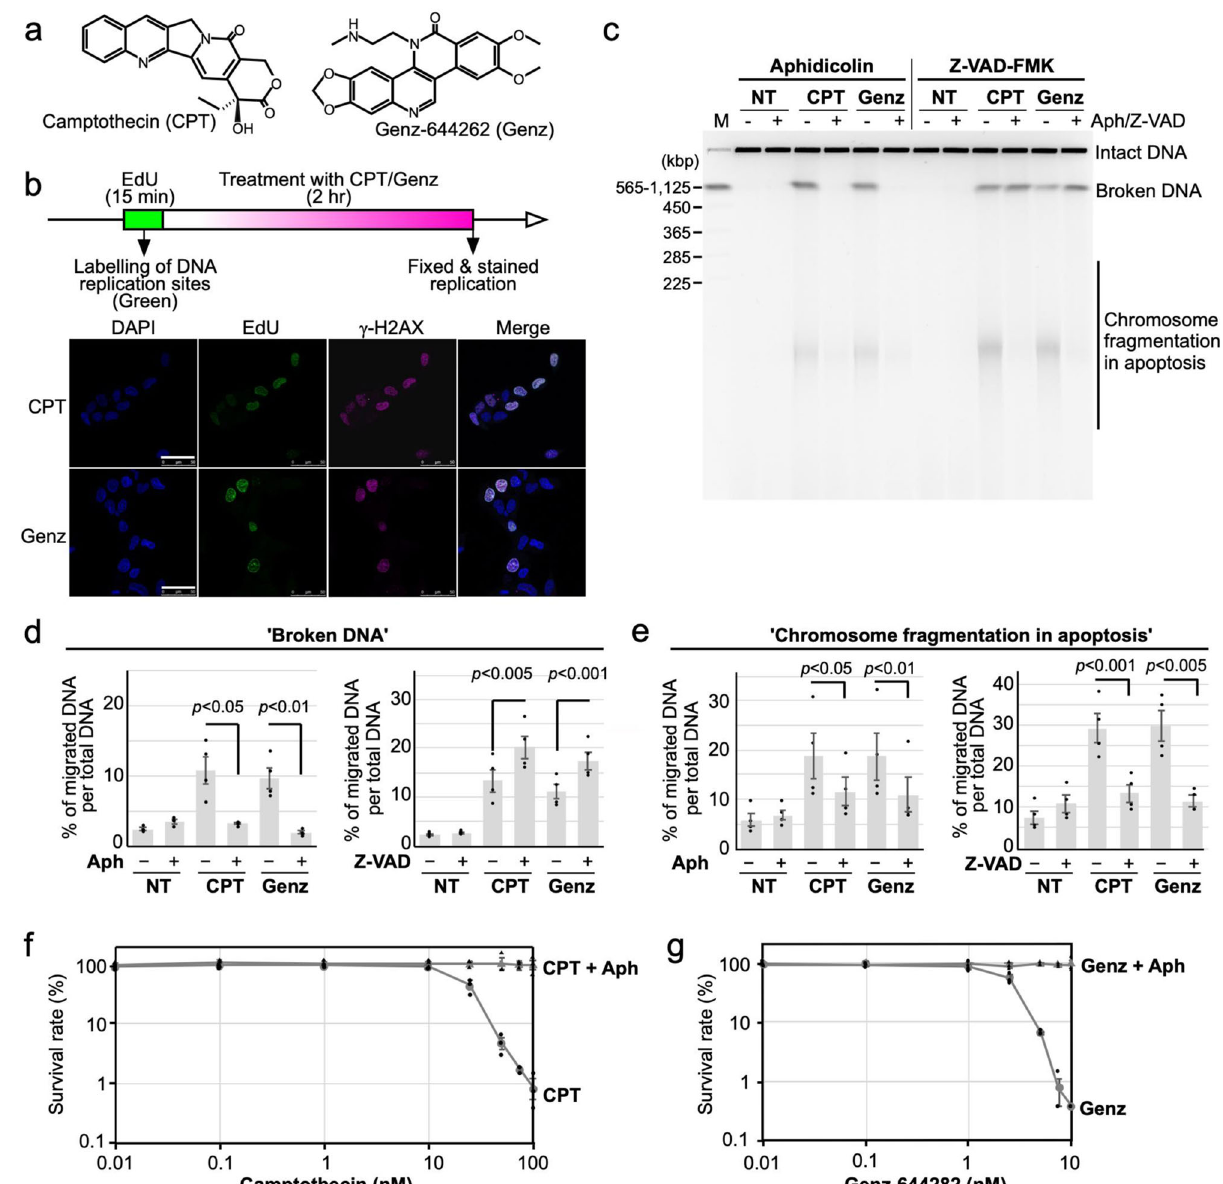
Fig. 1 Analysis of the cytotoxic effects of CPT and Genz. a Chemical structures of camptothecin (CPT) and Genz-644282 (Genz). b Immuno fl uorescence analysis of the formation of EdU and γ -H2AX foci. Cells were pulse-labelled with 10 μ M EdU for 15 min. Subsequently, these pulse-labelled cells were treated with 1 μ M CPT or 1 μ M Genz, and the formation of EdU and γ -H2AX foci was analysed. The scale bars represent 50 μ m. c PFGE analysis of DSB accumulation after 24 h-treatment with a DNA replication inhibitor, aphidicolin (10 μ M), combined with 1 μ M CPT and 1 μ M Genz, and PFGE analysis of DSB accumulation after 24 h-treatment with an apoptosis inhibitor, Z-VAD-FMK (10 μ M), combined with 1 μ M CPT and 1 μ M Genz. d Quanti fi cation of CPT- and Genz-induced ‘ broken DNA ’ , which represents DSB formation due to DNA stress. The data are presented as the percentages of the amount of broken DNA relative to total DNA (intact DNA + broken DNA + chromosome fragmentation in apoptosis). e Quanti fi cation of ‘ chromosome fragmentation in apoptosis ’ induced by treatments with CPT and Genz. The data are presented as the percentages of the amount of chromosome fragmentation in apoptosis per total DNA (intact DNA + broken DNA + chromosome fragmentation in apoptosis). The means and standard deviations were determined from four independent experiments. f Survival curve of SV40-transformed human fi broblasts, MRC5 against CPT. Indicated concentrations of CPT were applied for 24 h. Circle dots represents results of survival rates after treatment with CPT. Triangle dots represents results of survival rates after combined treatment with CPT and 10 μ M aphidicolin. g Survival curve of CPT on SV40-transformed MRC5 against Genz. Indicated concentrations of CPT was applied for 24 h. Circle dots represents results of survival rates after treatment with CPT. Triangle dots represents results of survival rates after combined treatment with CPT and 10 μ M